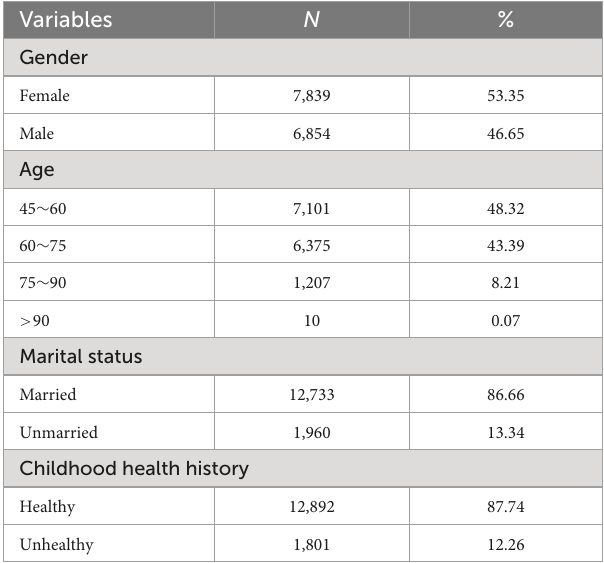
TABLE 1 Socio-demographic characteristics of